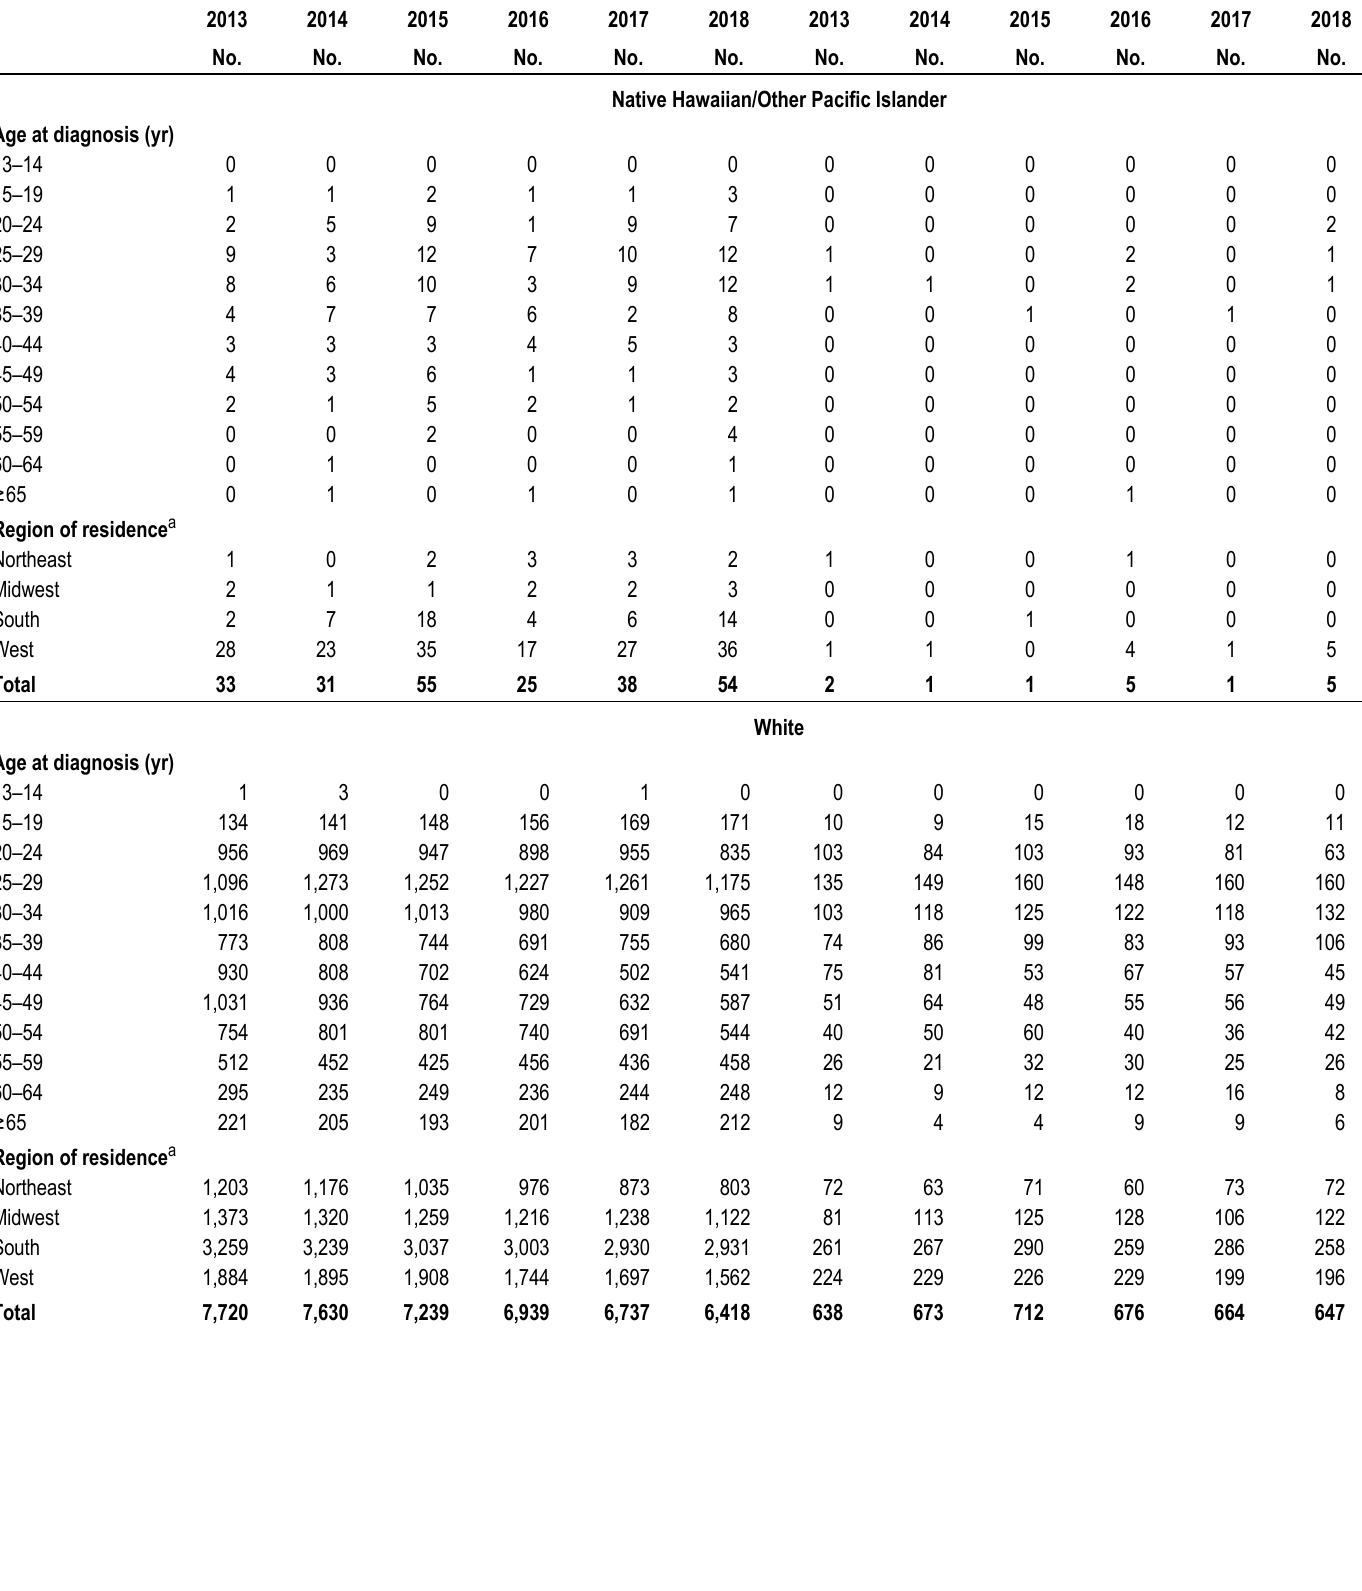
Table 7a.Diagnoses of HIV infection attributed to male-to-male sexual contact and male-to-male sexual contact and injection drug use, by selected characteristics, 2013–2018—United States (cont) Male-to-male sexual contact Male-to-male sexual contact and injection drug